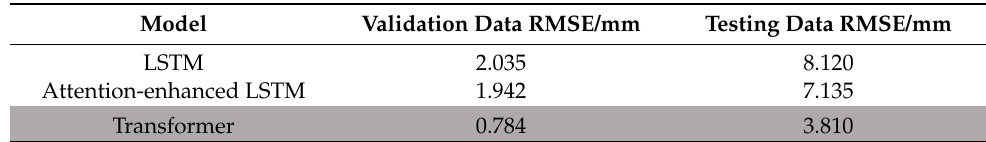
Table 4. Accuracy comparison of LSTM, attention-enhanced LSTM, and transformer with a similar model structure.